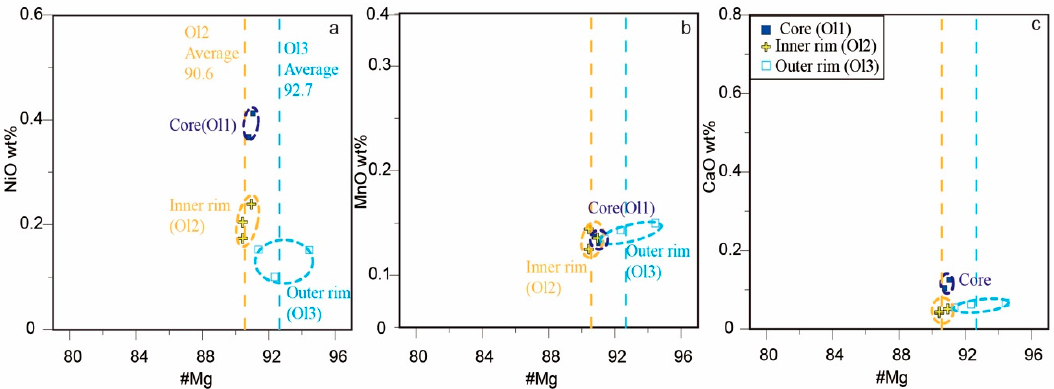
Figure 3. Compositional relations of ( a ) #Mg vs. NiO, ( b ) #Mg vs. MnO, and ( c ) #Mg vs. CaO of olivine at the Menominee kimberlite.